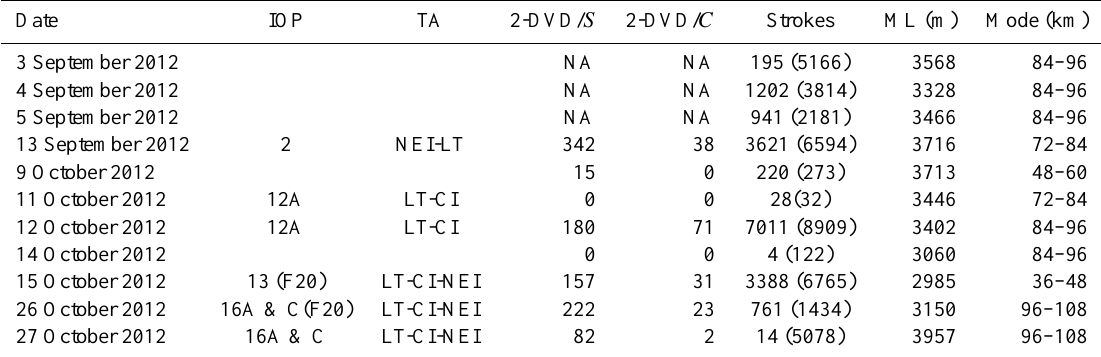
Table 3. Dates for which both radar and LINET data are simultaneously available. Second and third columns: HyMeX SOP 1.1 IOP number (with availability of the F20 flights), and the target area (TA) involved in the IOP. Fourth and fifth columns: stratiform ( S ) and convective ( C ) minutes measured by 2-DVD over the Sapienza site. Sixth column: number of LINET strokes that occurred during Polar 55 C observations and (in parentheses) the number of strokes in 24h. Seventh column: 0 ◦ C level height (in meters). Last column: mode of the distance to the radar of the peak of IWC g . NA represents data that are not